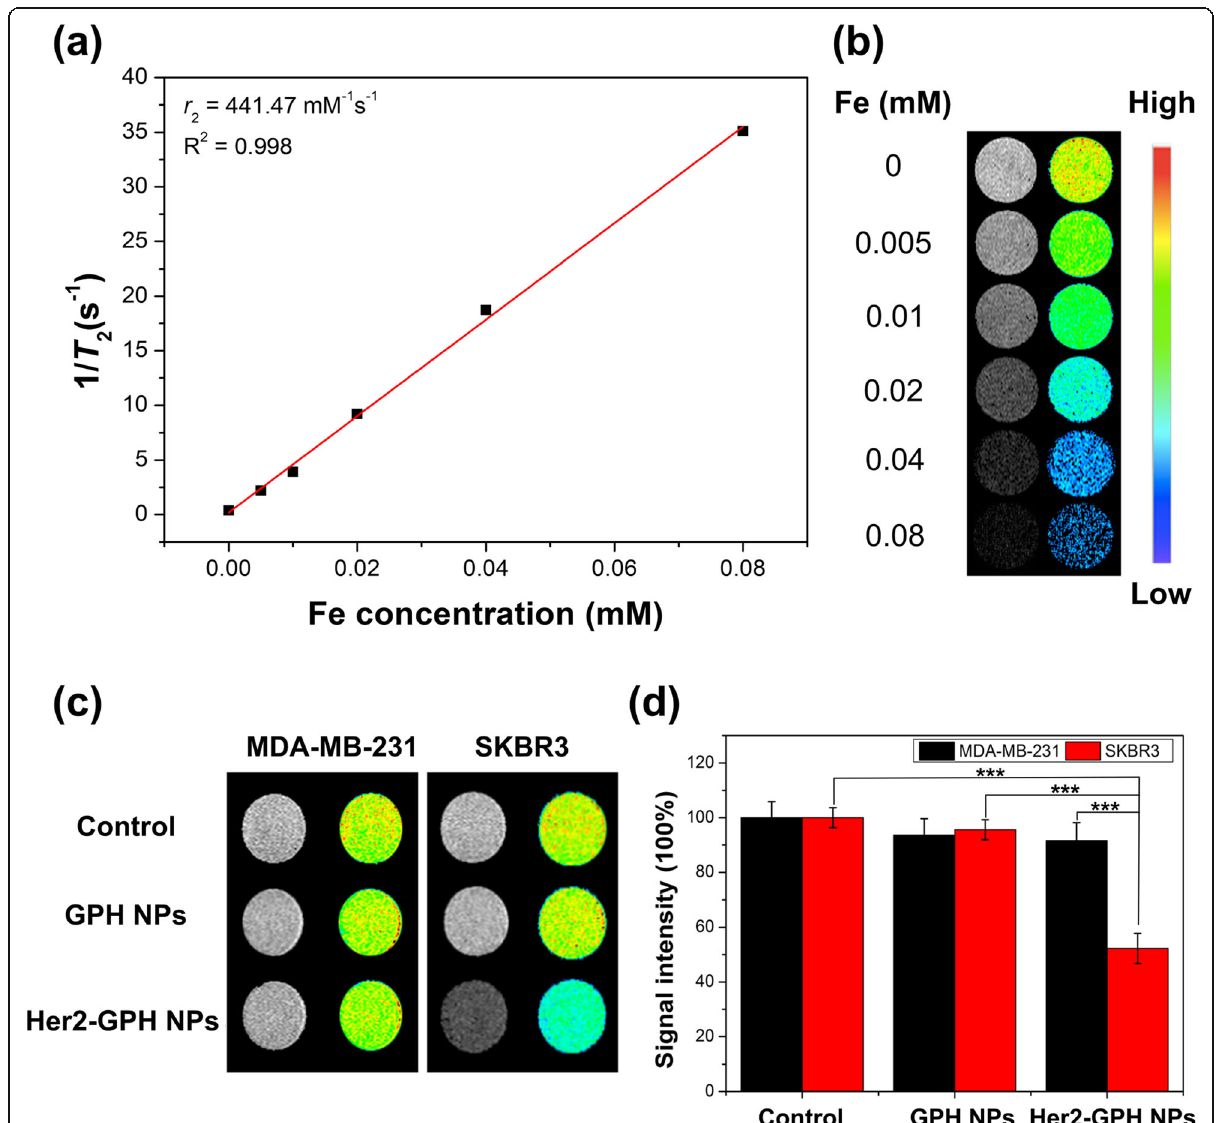
Fig. 10 In vitro MR imaging. a The transverse relaxation rates (1/ T 2 ) of Her2-GPH NPs aqueous solution as a function of the iron concentration in a 0.5T magnetic field. b T 2 -weighted MR images of Her2-GPH NPs with different iron concentrations acquired using spin-echo sequence. c T 2 -weighted MR images and d signal intensity of Her2-GPH NPs (100 μ g/mL) and GPH NPs (100 μ g/mL) incubated with MDA-MB-231 and SKBR3 cells. MDA-MB-231 and SKBR3 cells served as controls (data expressed as mean±SD, * P <0.05, ** P <0.01, *** P <0.001, n